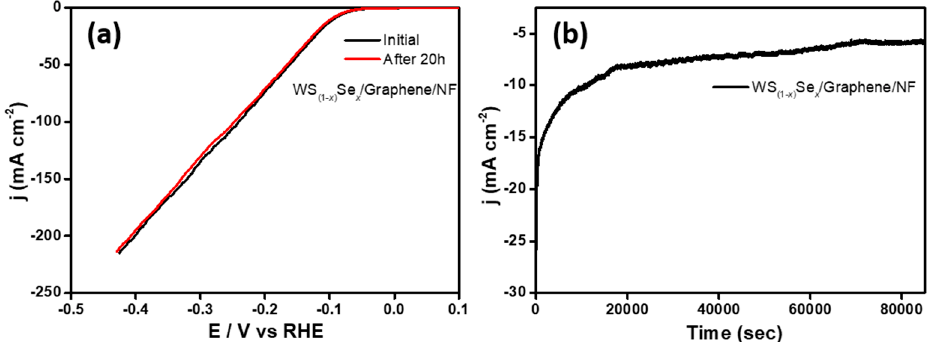
Figure 7. LSV curves for WS (1 − x ) Se x /graphene/NF before and after 20 h HER performance. Time dependent current density variation of WS (1 − x ) Se x /graphene/NF catalyst at a constant applied potential of − 93 mV for more than 20 h.